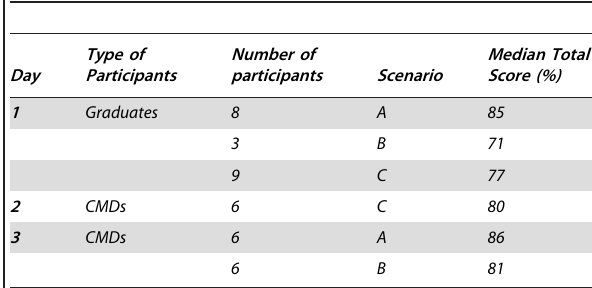
Table 2. Use of passive reporting form over three pretesting and revision